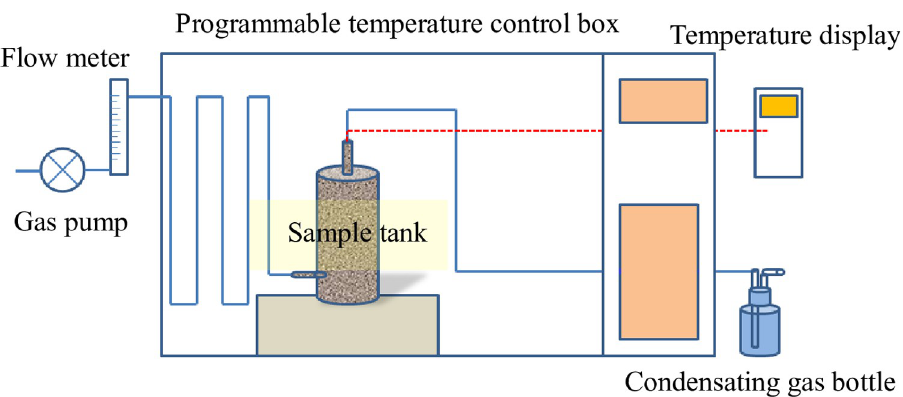
Fig 2. Experimental device for coal oxidation spontaneous